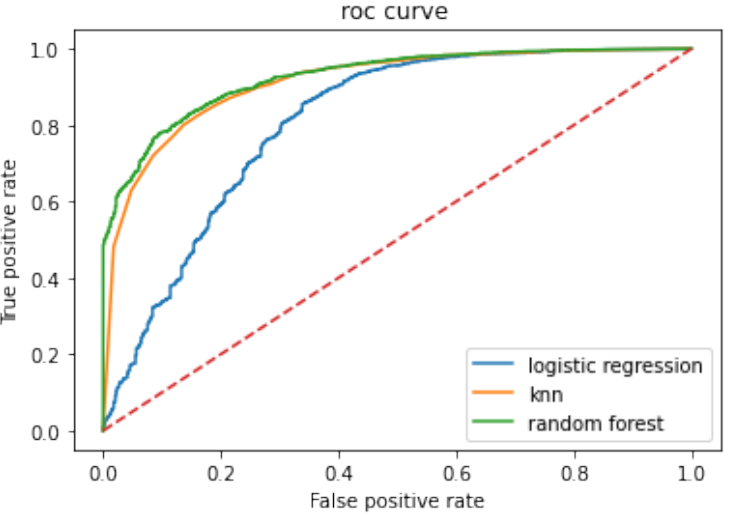
Figure 11. ROC curve of model prediction effect